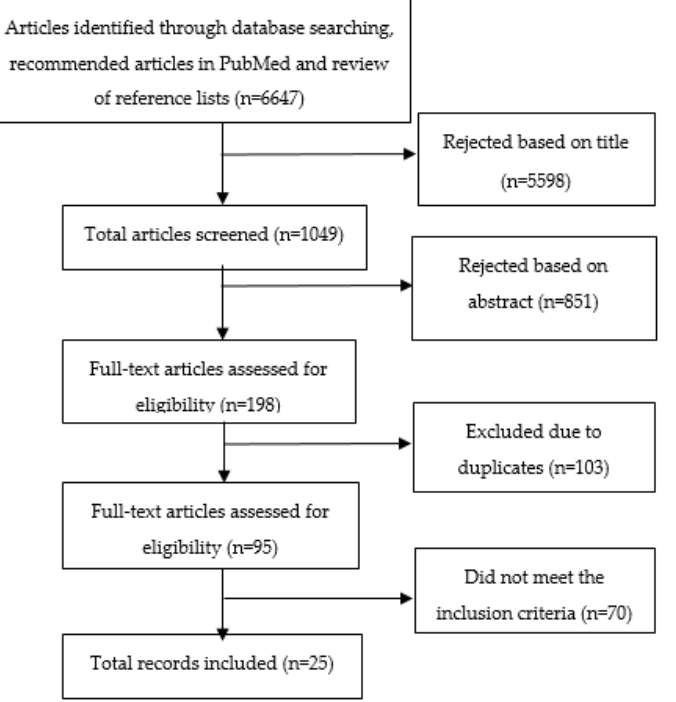
Figure 1. Flow chart of the article selection process.